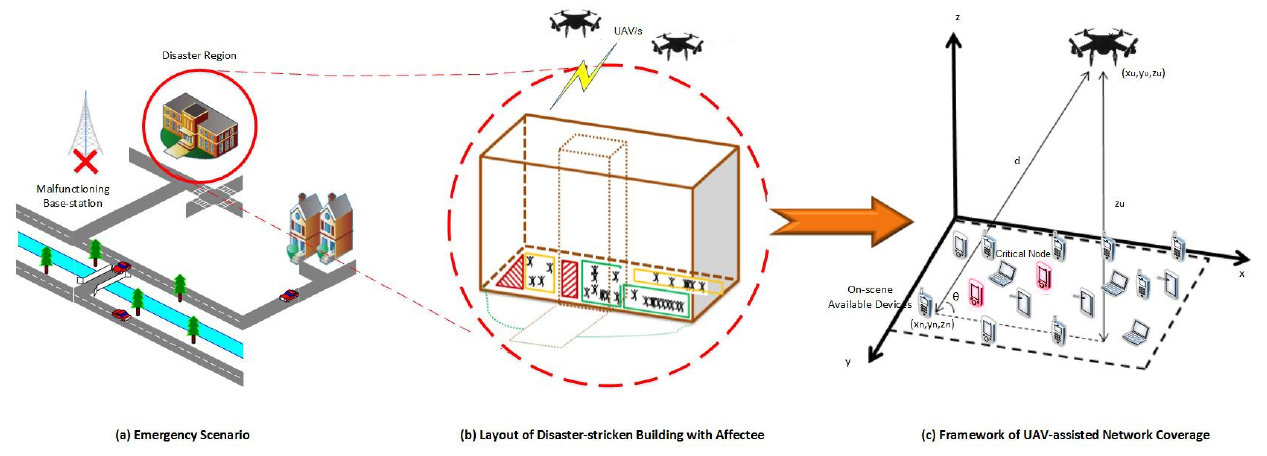
Figure 1. System